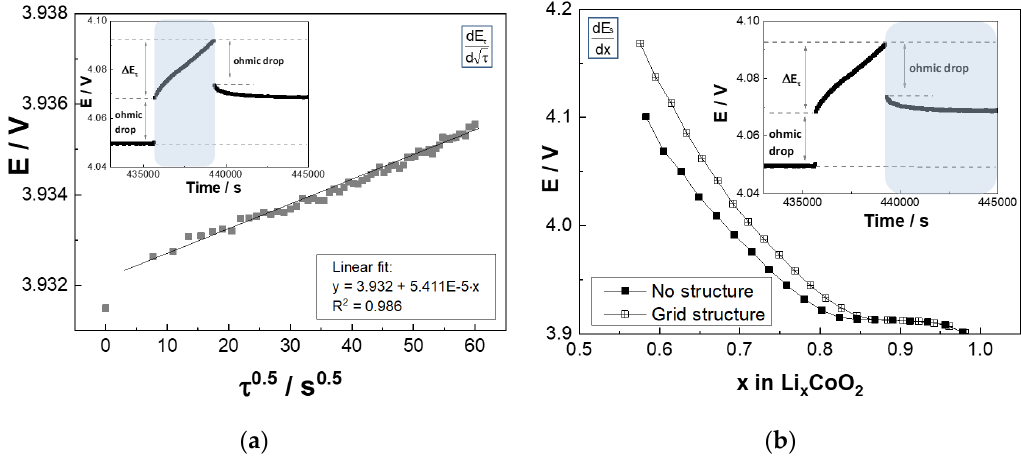
and ( b ) equilibrium potentials. Insets are (cid:26) (cid:28) (cid:26) (cid:27)